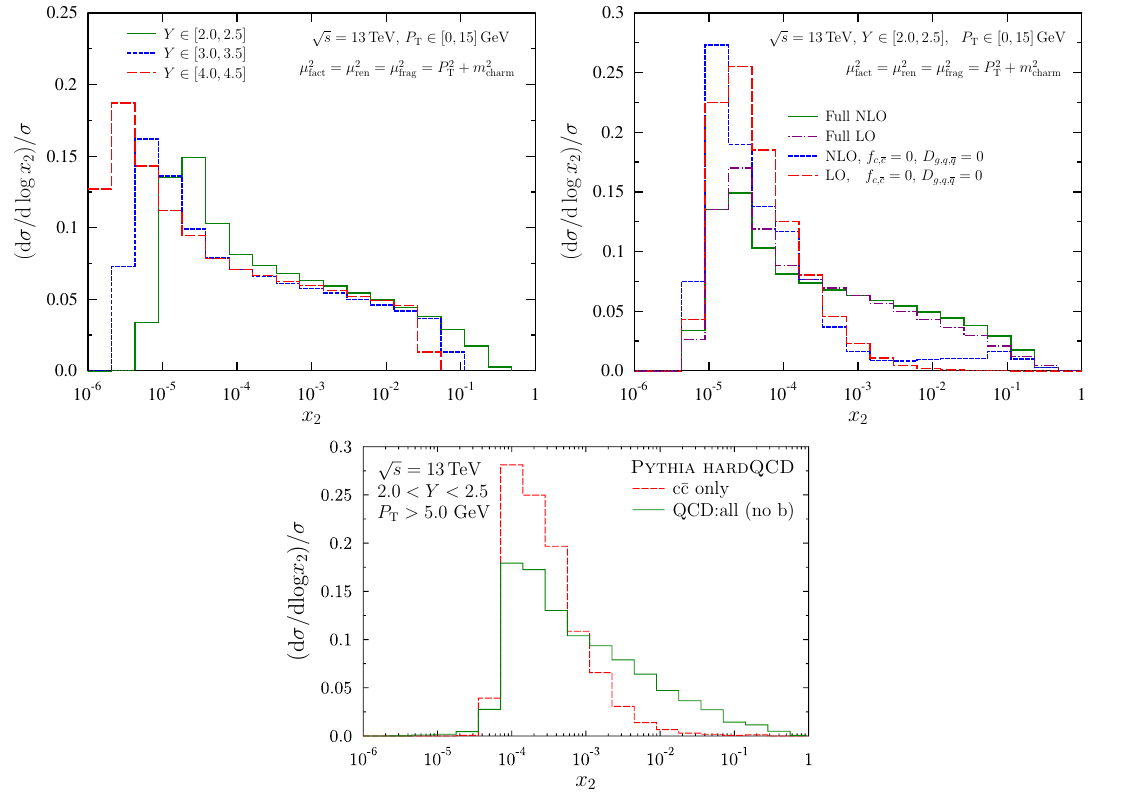
Figure 6 . Upper left panel: the x 2 distributions for D 0 -meson production in SACOT- m T scheme p at s = 13 TeV for Y 2 [2 ; 2 : 5] (green solid line), Y 2 [3 ; 3 : 5] (blue dashed line), and Y 2 [4 ; 4 : 5] (red dashed line). Upper right panel: the x 2 distributions for rapidity interval Y 2 [2 ; 2 : 5] from full NLO calculation (green solid line), full LO calculation (purple dashed-dotted line), partial NLO calculation with heavy-quark PDFs and light-parton FFs set to zero (blue dashed line), and partial LO calculation with heavy-quark PDFs and light-parton FFs set to zero (red long-dashed line). Lower panel: the x 2 distributions from a Pythia simulation from cc events only (green solid line), and including all (excluding b quarks) QCD processes (red dashed